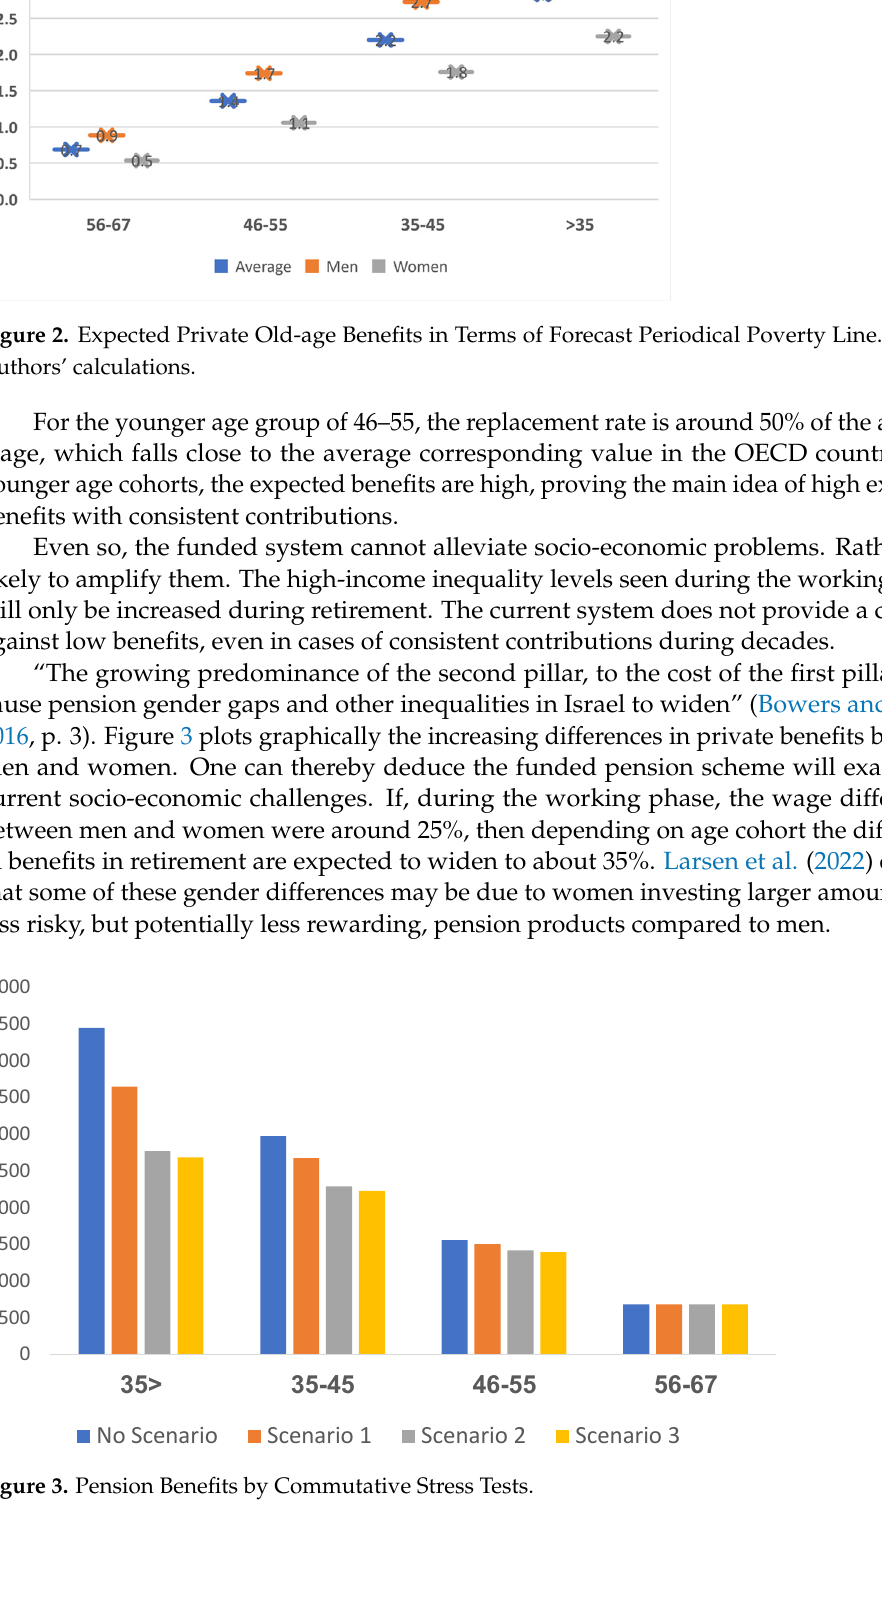
Figure 3. Pension Benefits by Commutative Stress Tests.